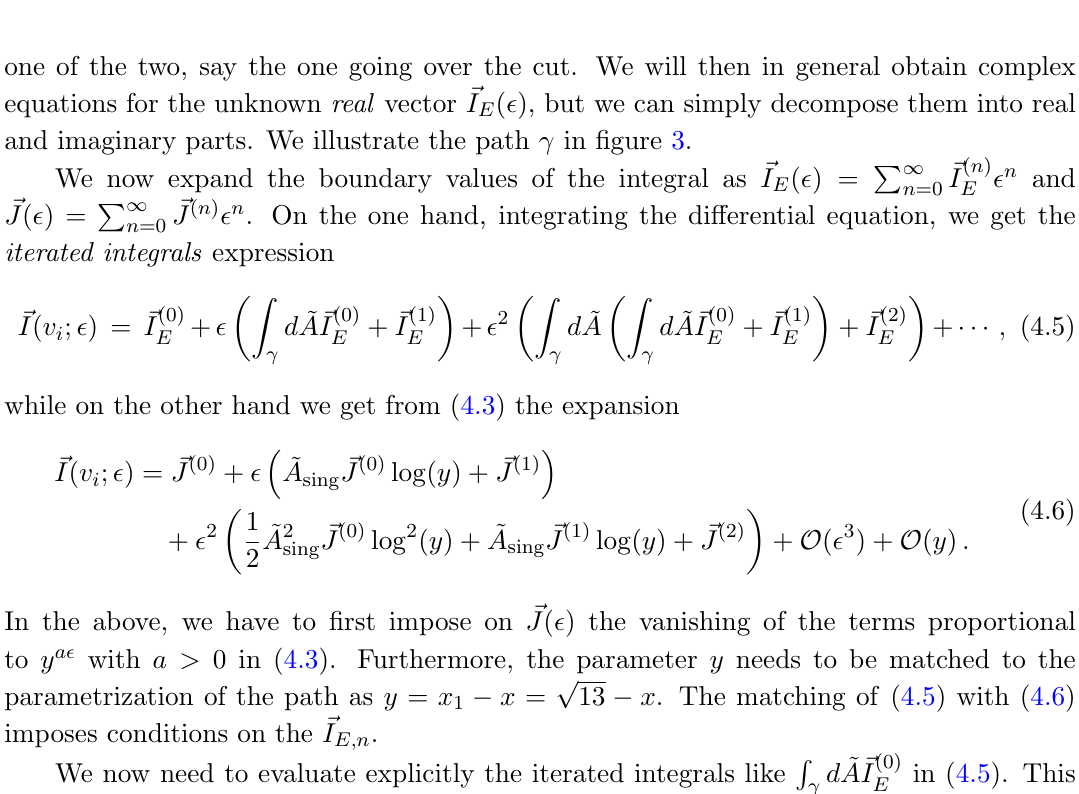
Figure 3 . The integration path (4.4), going under the pole at ˜ x = 3, is shown by the thick blue curve. Zeros of the letters (2.3) are marked by red